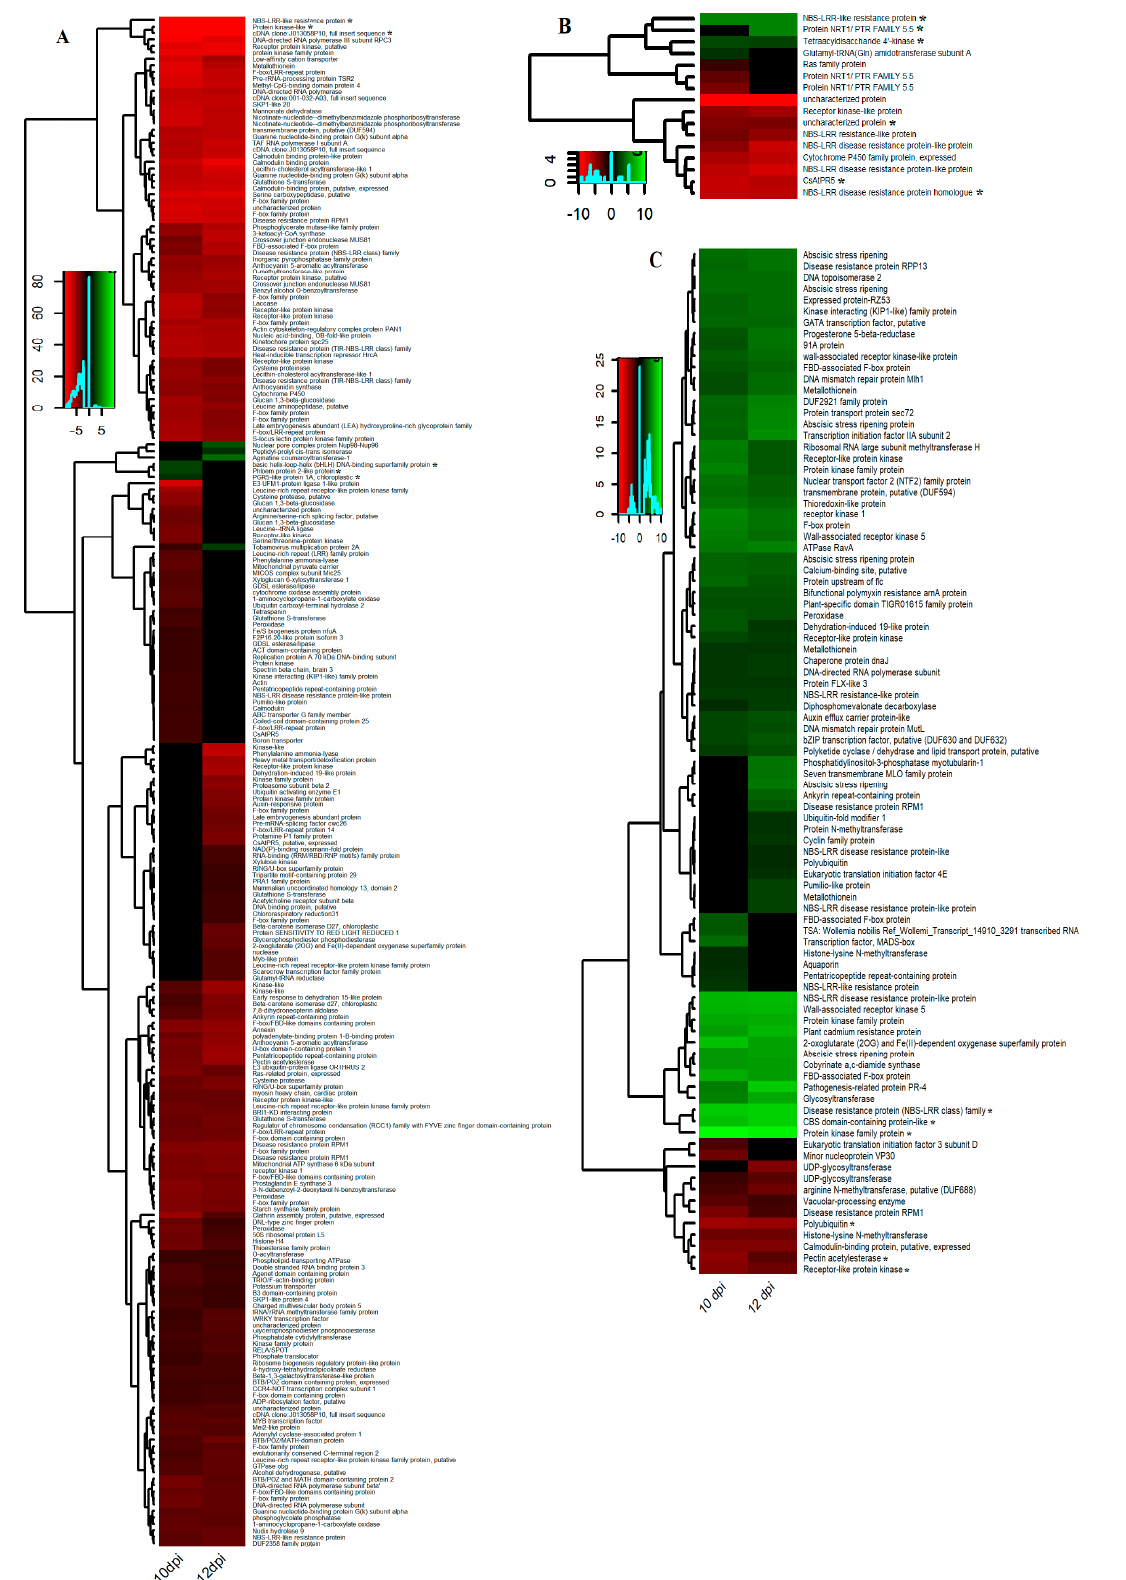
Figure 9. Heatmap of different gene expression profiles ( ≥ 2-fold, FDR ≤ 0.05) after infection with STB at 10 and 12 dpi. The DEGs were localized in ( A ) 1BS, ( B ) 2BL and ( C ) 3DL QTL intervals. The star indicates the expression of the six highly up and down regulated genes in the QTL intervals.